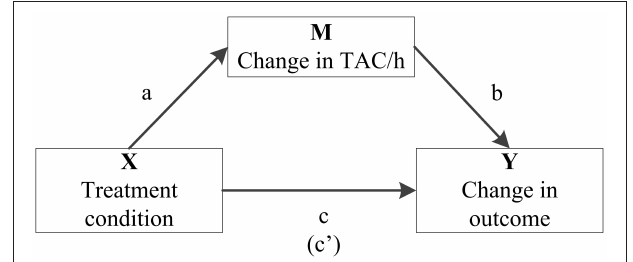
FIGURE 1 | Model summarizing how the role of change in average total activity counts per hour (TAC/h) as a potential mediator (M) in the association between treatment condition (X) and significant change in medication use (Y) is quantified in mediation analysis. It includes the associations between treatment condition and TAC/h (a), TAC/h and the particular outcome variable (b) and treatment condition on the particular outcome variable (c). The coefficient between the latter two, controlling for change in TAC/h, is in parentheses (c ′ ).